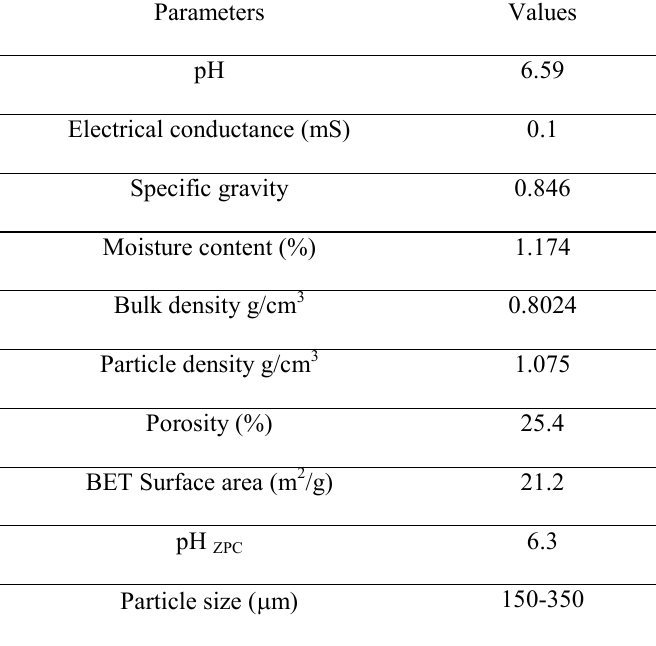
Table 1. Physico-chemical characteristics of eggshell